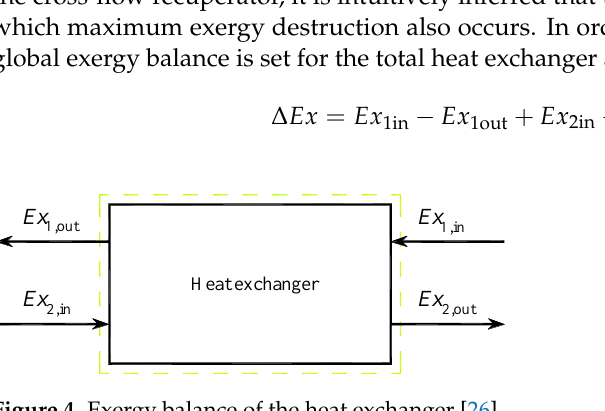
Figure 4. Exergy balance of the heat exchanger [26].